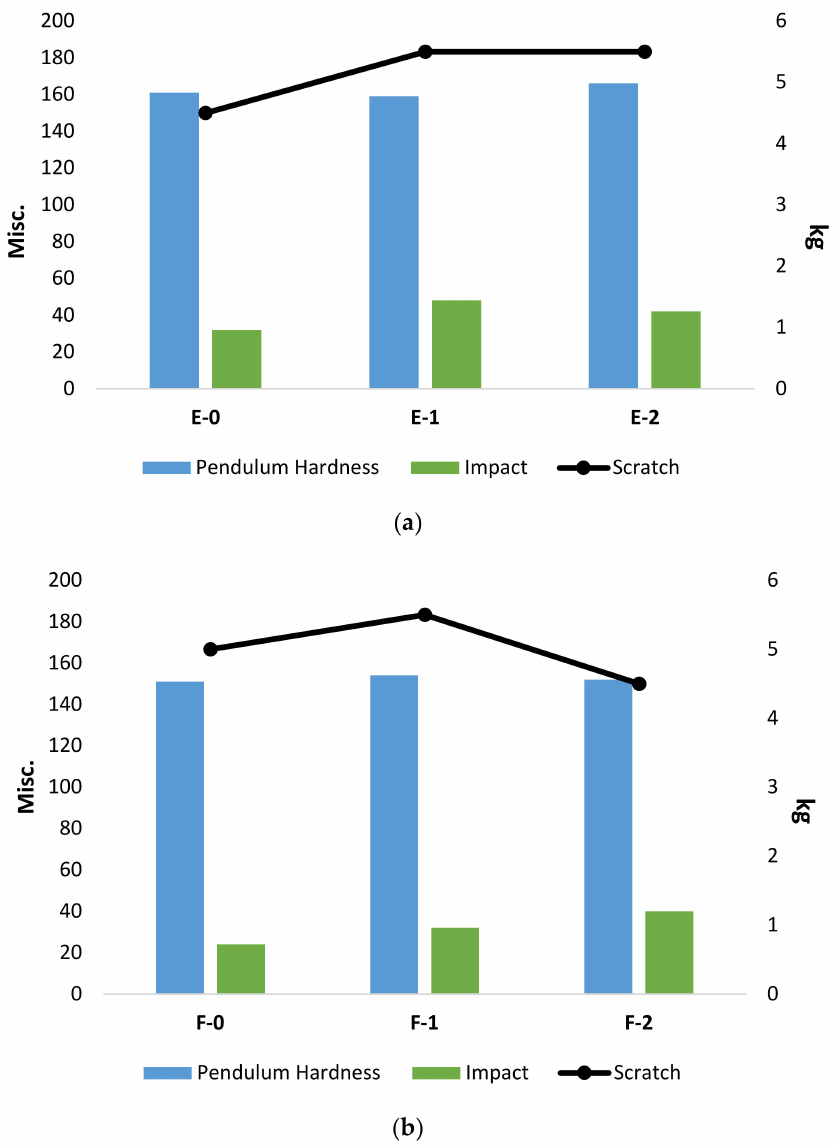
Figure 5. Graphical Representation of obtained mechanical properties ( a ) Coatings prepared with PA-450, ( b ) Coatings prepared with